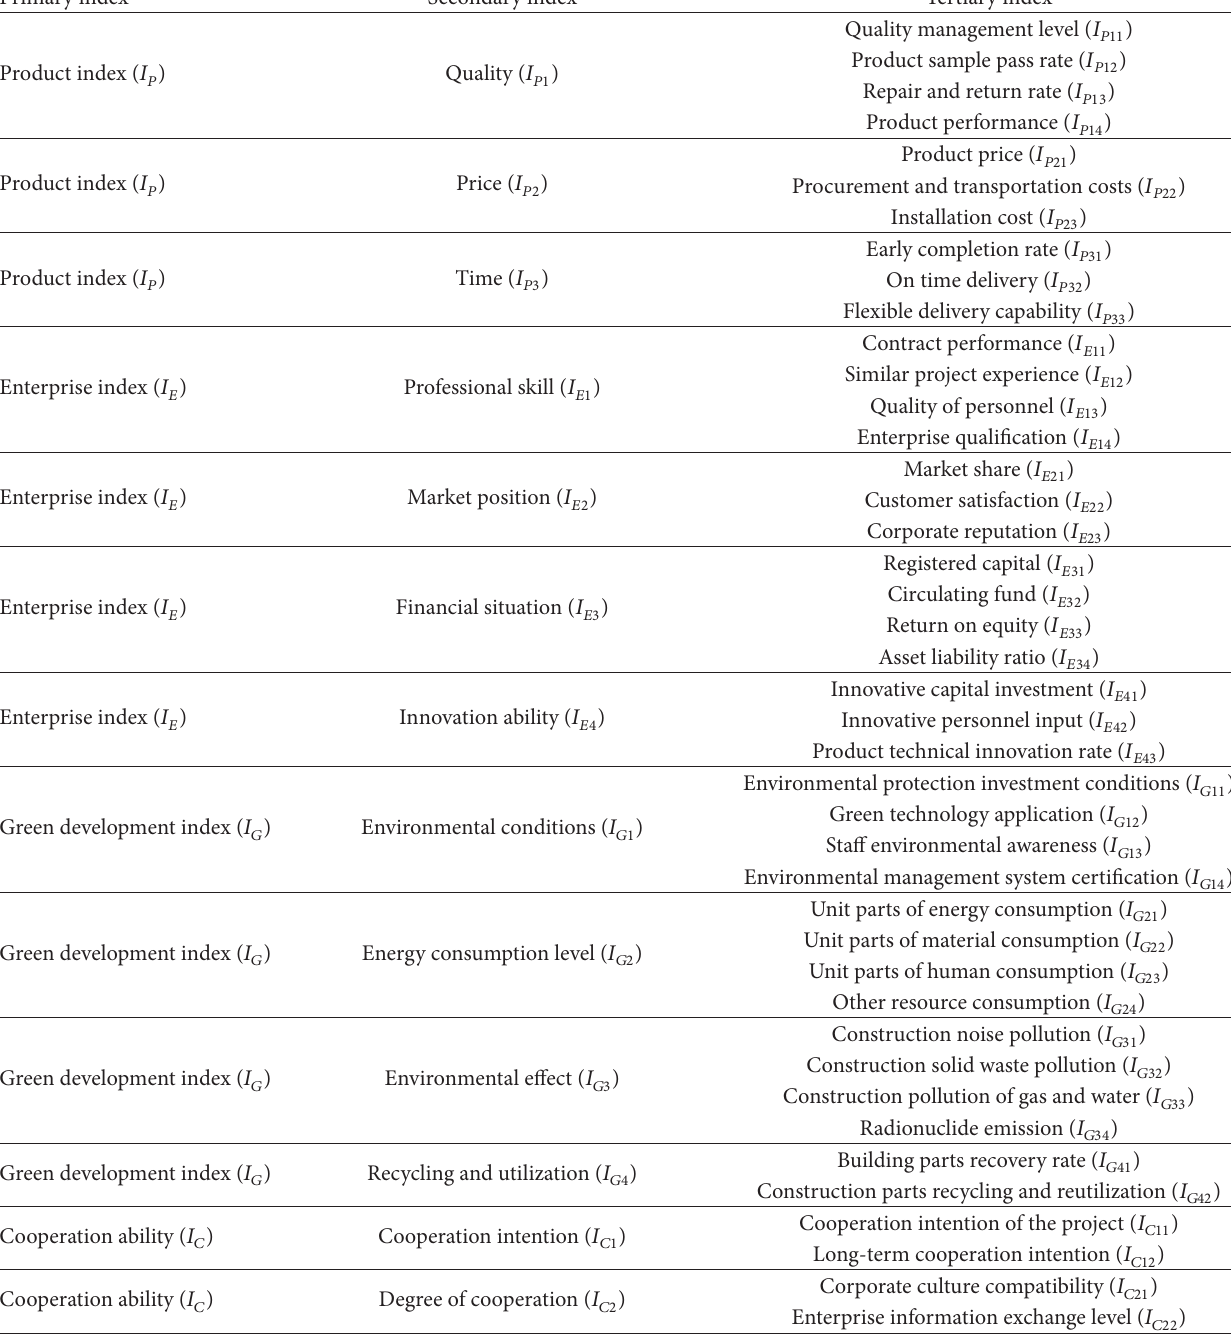
Table 2: Evaluation index system of green building parts